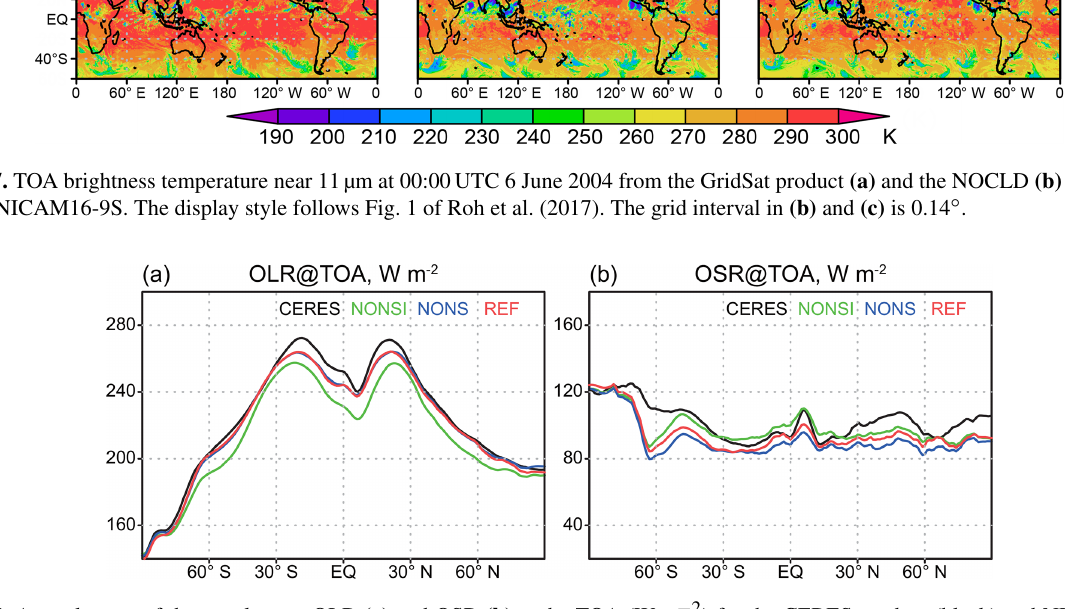
Figure 8. Annual mean of the zonal mean OLR (a) and OSR (b) at the TOA (Wm − 2 ) for the CERES product (black) and NICAM16-9S. Green, blue, and red curves show the NONSI, NONS, and REF runs,